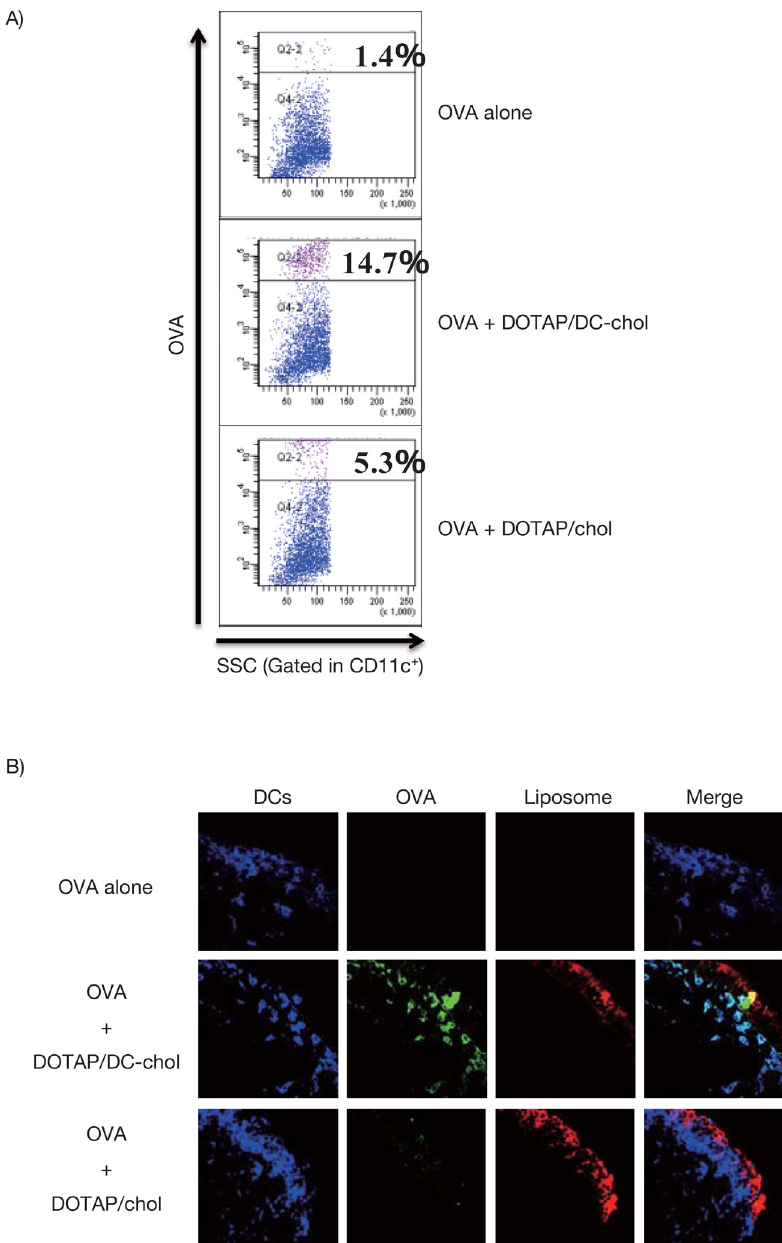
Fig 10. Antigen uptake by CD11c + DCs in NALTs following intranasal administration of Alexa Fluor- labelled OVA plus the cationic liposomes. BALB/c female mice were intranasally administered Alexa Fluor 488-OVA (5 μ g/mouse) alone, or Alexa Fluor 488-OVA (5 μ g/mouse) plus DOTAP/DC-chol liposomes, or DOTAP/chol liposomes. NALTs were collected 1 h after administration. (A) The NALT cells obtained were stained with anti-mouse CD11c mAb. Alexa Fluor 488-OVA uptake by DCs (based on CD11c + gating) was analysed by flow cytometry, and (B) 8- μ m frozen sections of NALTs were stained with antibodies against CD11c (DCs are depicted in blue). Co-localization of OVA, DOTAP/DC-chol liposomes or DOTAP/chol liposomes, and DCs in the cryosections was observed by fluorescence microscopy.